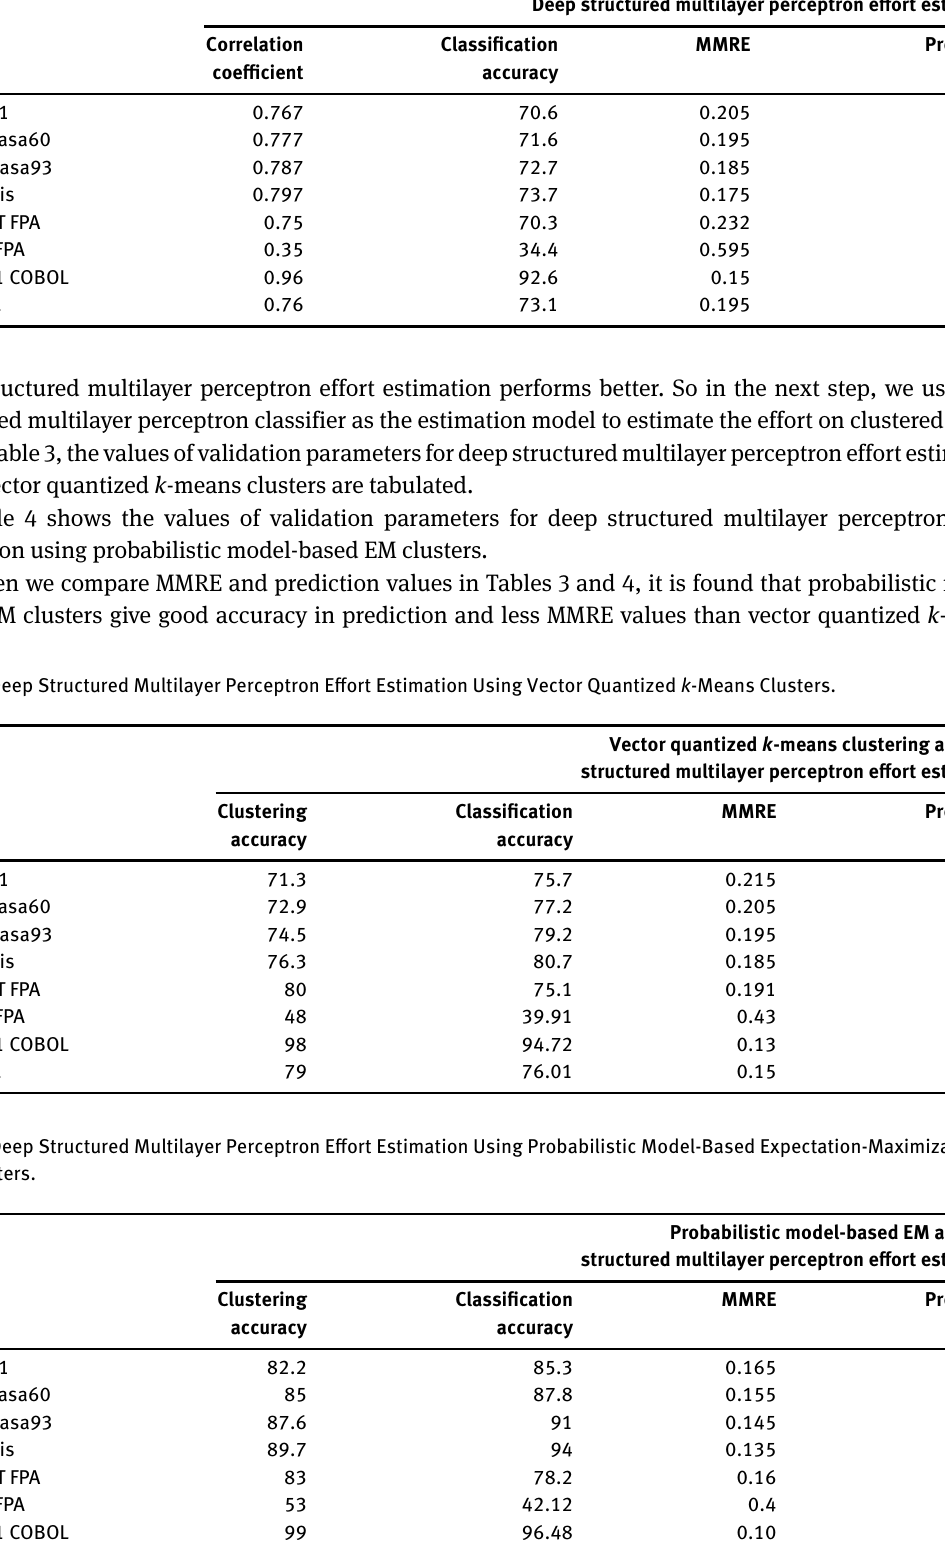
Table 2: Validation Parameters’ Values for Deep Structured Multilayer Perceptron Effort Estimation. Dataset